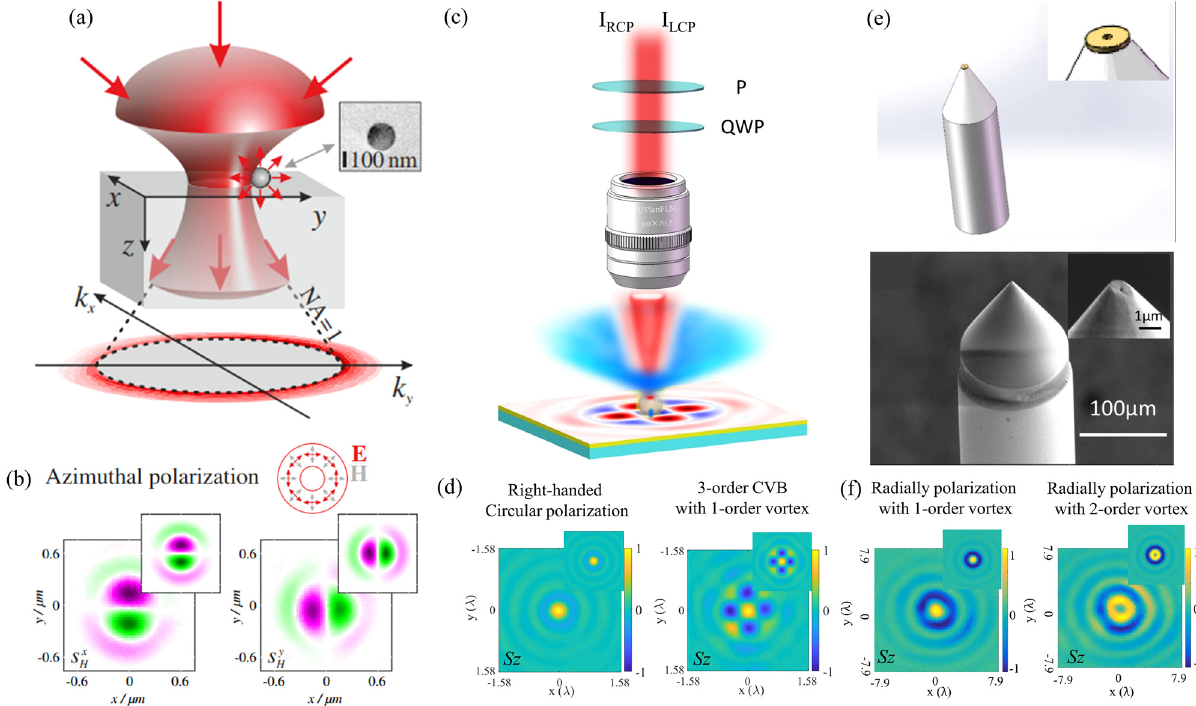
Figure 7: Experimentaltools developed for measuring the transverseSAM:(a) and (b)a Si-nanoparticle,of which thescattering pattern at the Fourier domain is related strongly to the transverse spin, was employed for measuring the transverse SAM density of focused vector beams associated with the longitudinal fi elds (i.e., the in-plane transverse spin) [55]. (c) and (d) A nanoparticle-on- fi lm structure, designed to be sensitive to the transversal fi eld component, was employed to map the near- fi eld distribution of the out-of-plane transverse SAM component ofSPPs[76].(e)and(f)Atapered fi berprobesensitivetothetransversal fi eldwasemployedtomaptheout-of-planeSAMcomponentofvarious focused cylindrical vector beams